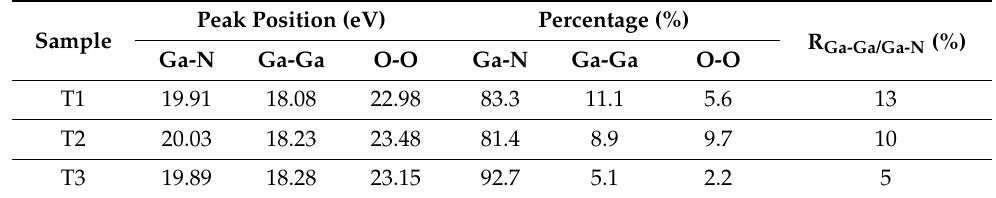
Table 2. Summary of a fitting parameter for Ga-3d core-level spectra (Figure 4). Peak position, percentage, and the ratio of the area under an individual peak.